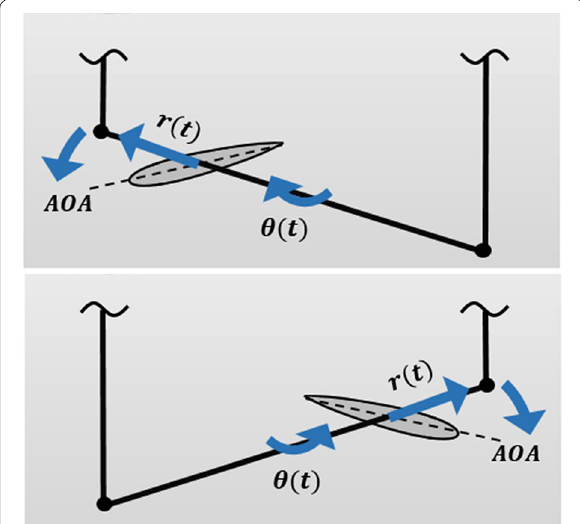
Fig. 6 Active control of foil-shaped slider. The figure shows the direction of the slider’s linear motion r ( t ) and its rotaion (AOA) with respect to the frame, in two cases of clockwise (upper figure) and counterclockwise (below figure) pitch deviation θ( t ) of the